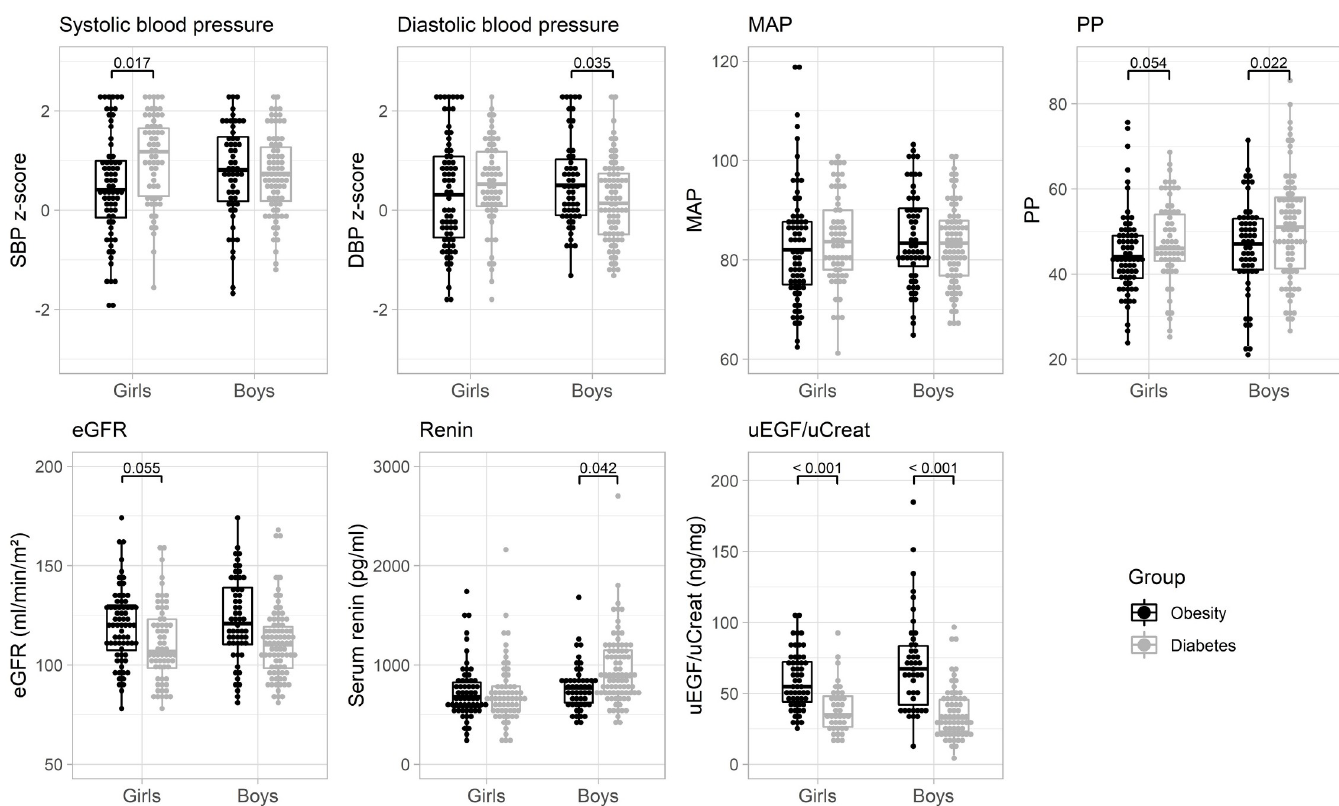
Fig 1. Boxplots represent differences in blood pressure related variables (upper panel) and kidney related variables (lower panel) between boys and girls with T1DM (light grey) and obesity (black). MAP: mean arterial pressure; PP: pulse pressure; eGFR: estimated glomerular filtration rate; uEGF: urinary epidermal growth factor; uCreat: urinary